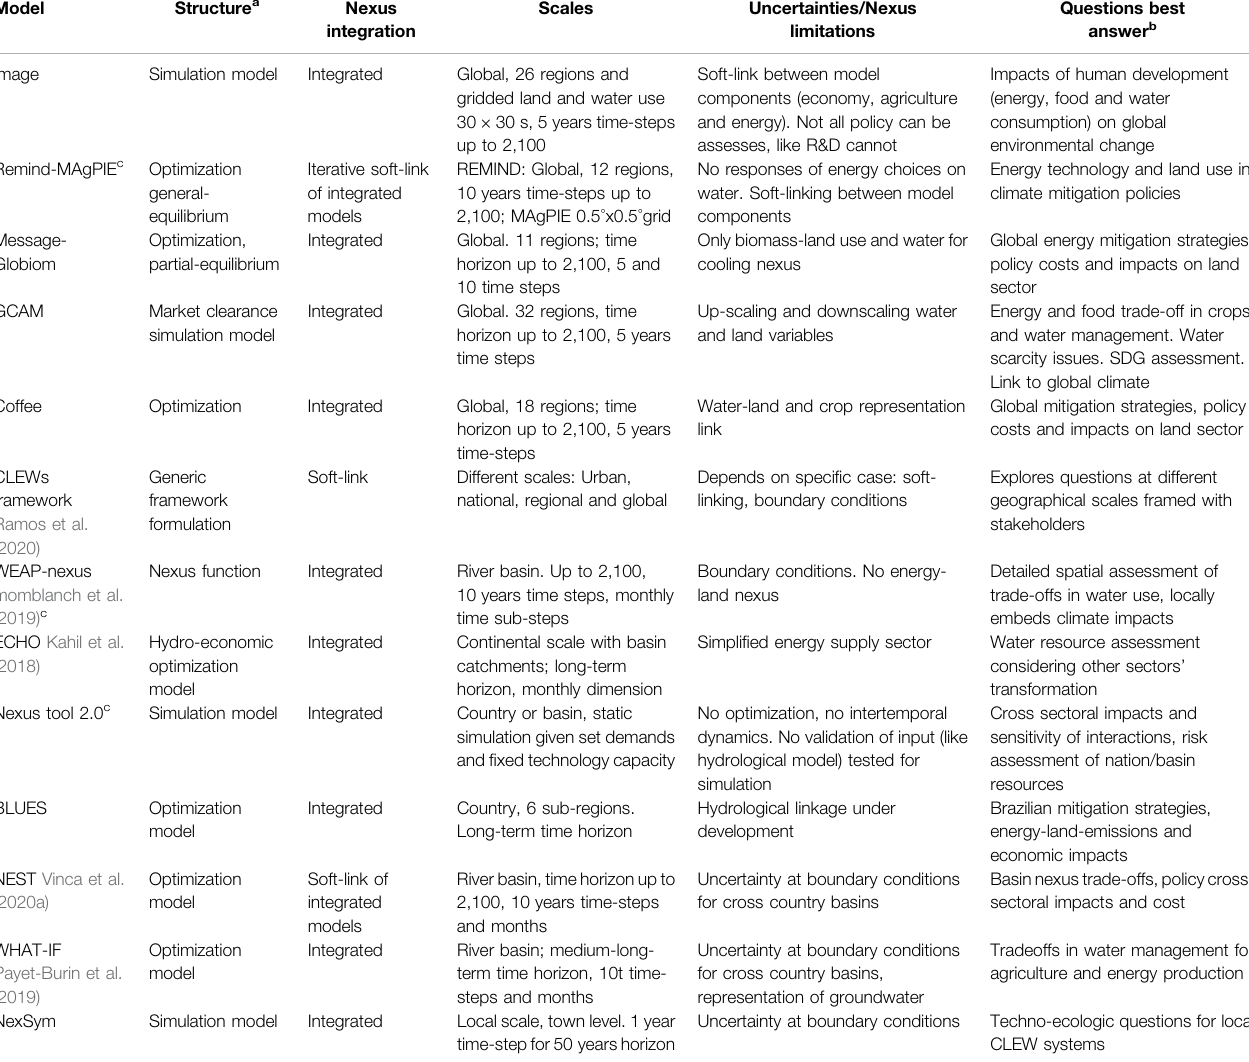
TABLE 1 | Comparison of CLEW